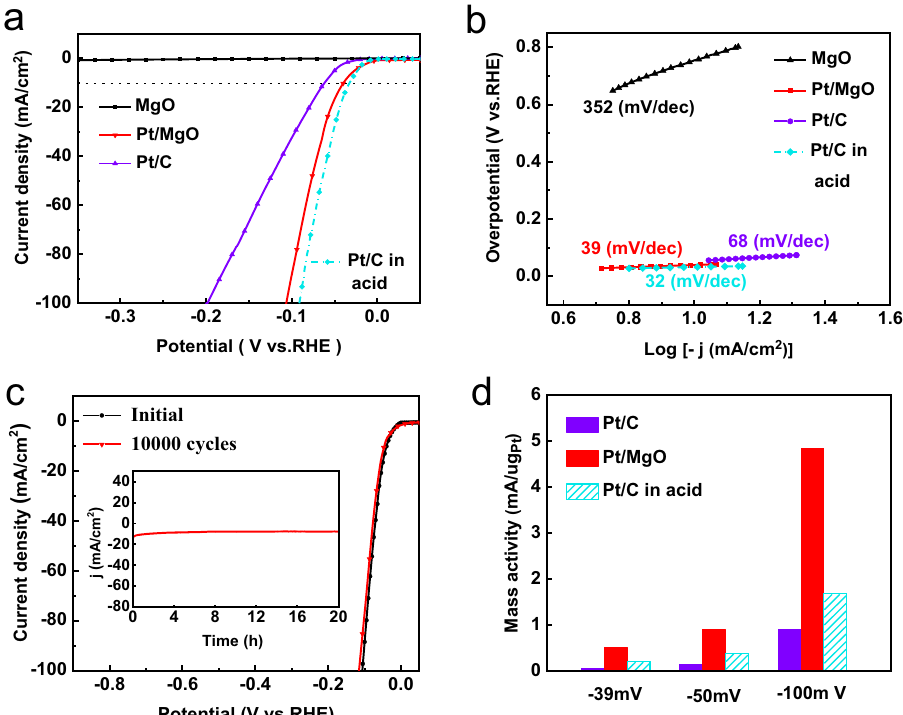
Fig. 3 Electrocatalytic performance of Pt/MgO and reference samples for the HER. a Linear sweep voltammetry (LSV) curves of Pt/MgO, Pt/C, and MgO in 1 M KOH, with that of Pt/C in H 2 SO 4 obtained for comparison. b The corresponding Tafel plots were calculated from the LSV curves of Pt/MgO, Pt/C, and MgO. c The initial and 10,000th polarization curves recorded from Pt/MgO in 1 M KOH (inset: chronopotentiometric curve at a current density of 10 mA cm − 2 ). d Comparison of the mass activity of Pt/MgO and Pt/C under various